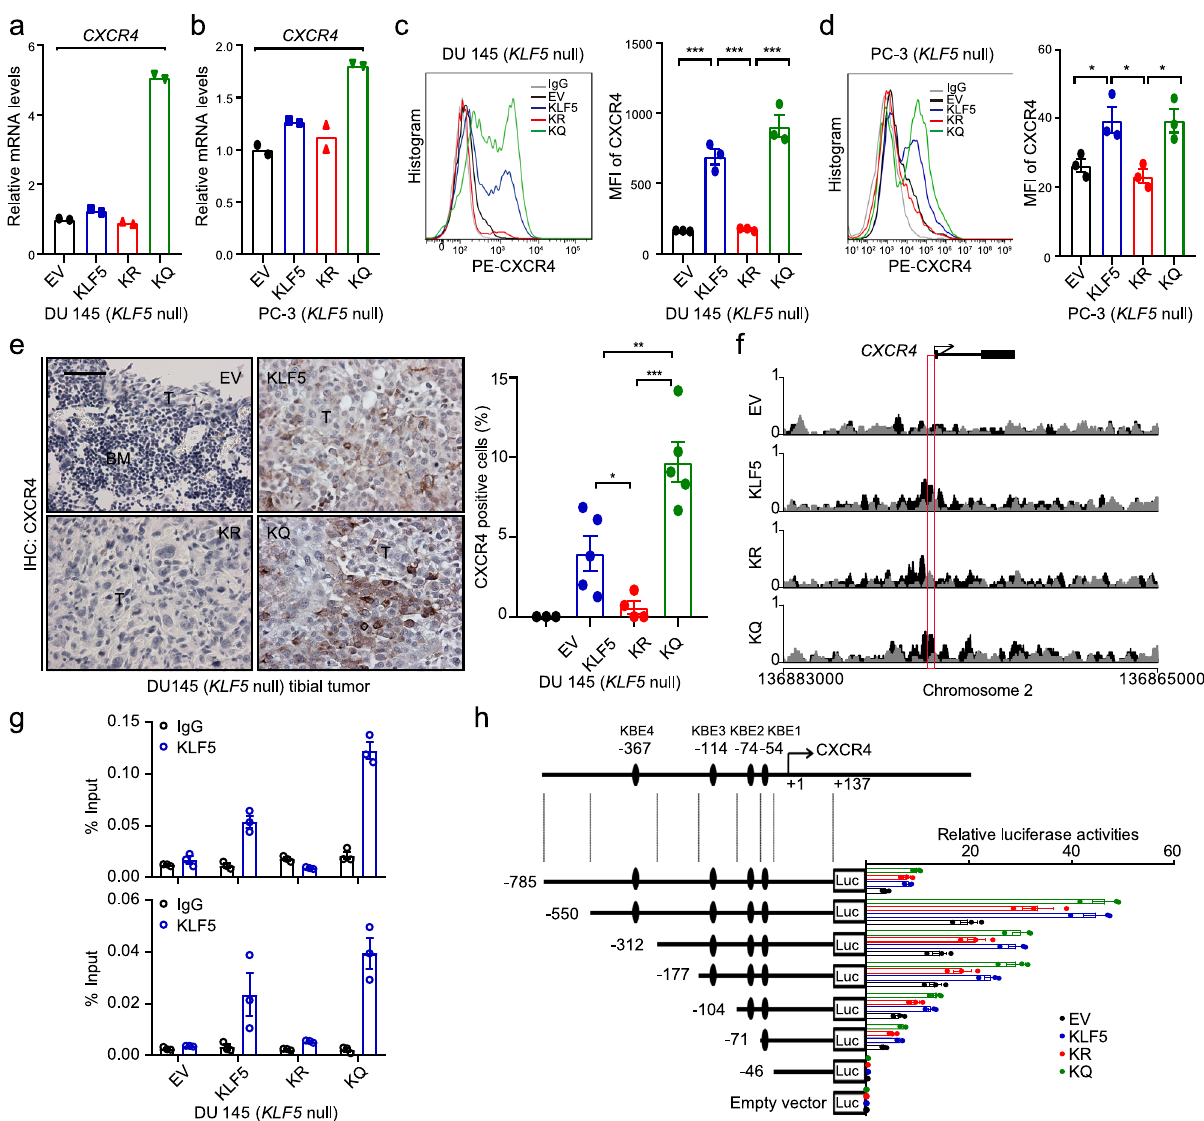
Fig. 6 Acetylation of KLF5 activates the transcription of CXCR4 in PCa cells. a – d Expression of CXCR4, as detected by real-time qPCR ( a , b ) and fl ow cytometry ( c , d ), in DU 145 cells ( a , c ) and PC-3 cells ( b , d ) expressing different forms of KLF5 in in vitro 2-dimentiomal cultures. MFI mean fl uorescent intensity. Experiments were performed in duplicate for real-time qPCR ( a , b ) and in triplicate for fl ow cytometry ( c , d ). See more details of panels c and d in Supplementary Fig. 8a. e IHC staining of CXCR4 in tumor-bearing bone samples. Rates of CXCR4-positive cells are shown at the right. BM bone marrow region, T tumor region. Scale bar, 50 μ m. n = 3, 5, 4, and 5 tumors for EV, KLF5, KR, and KQ groups respectively. f , g A region in the CXCR4 promoter, indicated by a red box, is speci fi cally bound by KLF5 KQ (KQ) but not by KLF5 KR (KR), as demonstrated by ChIP-Seq analysis ( f ) and validated by ChIP-PCR with two different pairs of primers targeting the region ( g ). ChIP-PCR was performed in triplicate using in vitro two-dimentiomal cultures. h KQ is more potent than KR in the activation of CXCR4 promoter, as revealed by promoter-luciferase reporter assay of different CXCR4 promoter regions. Black ellipse, putative KLF5 binding motifs (KB) predicted by the oPROF web-based software. + 1, transcription start site. Promoter-luciferase reporter assay was performed in triplicate. In panels c – e , data are shown in mean ± S.E.M. * p < 0.05; ** p < 0.01; *** p < 0.001 (two-tailed Student ’ s t test). Source data are provided as a Source Data fi